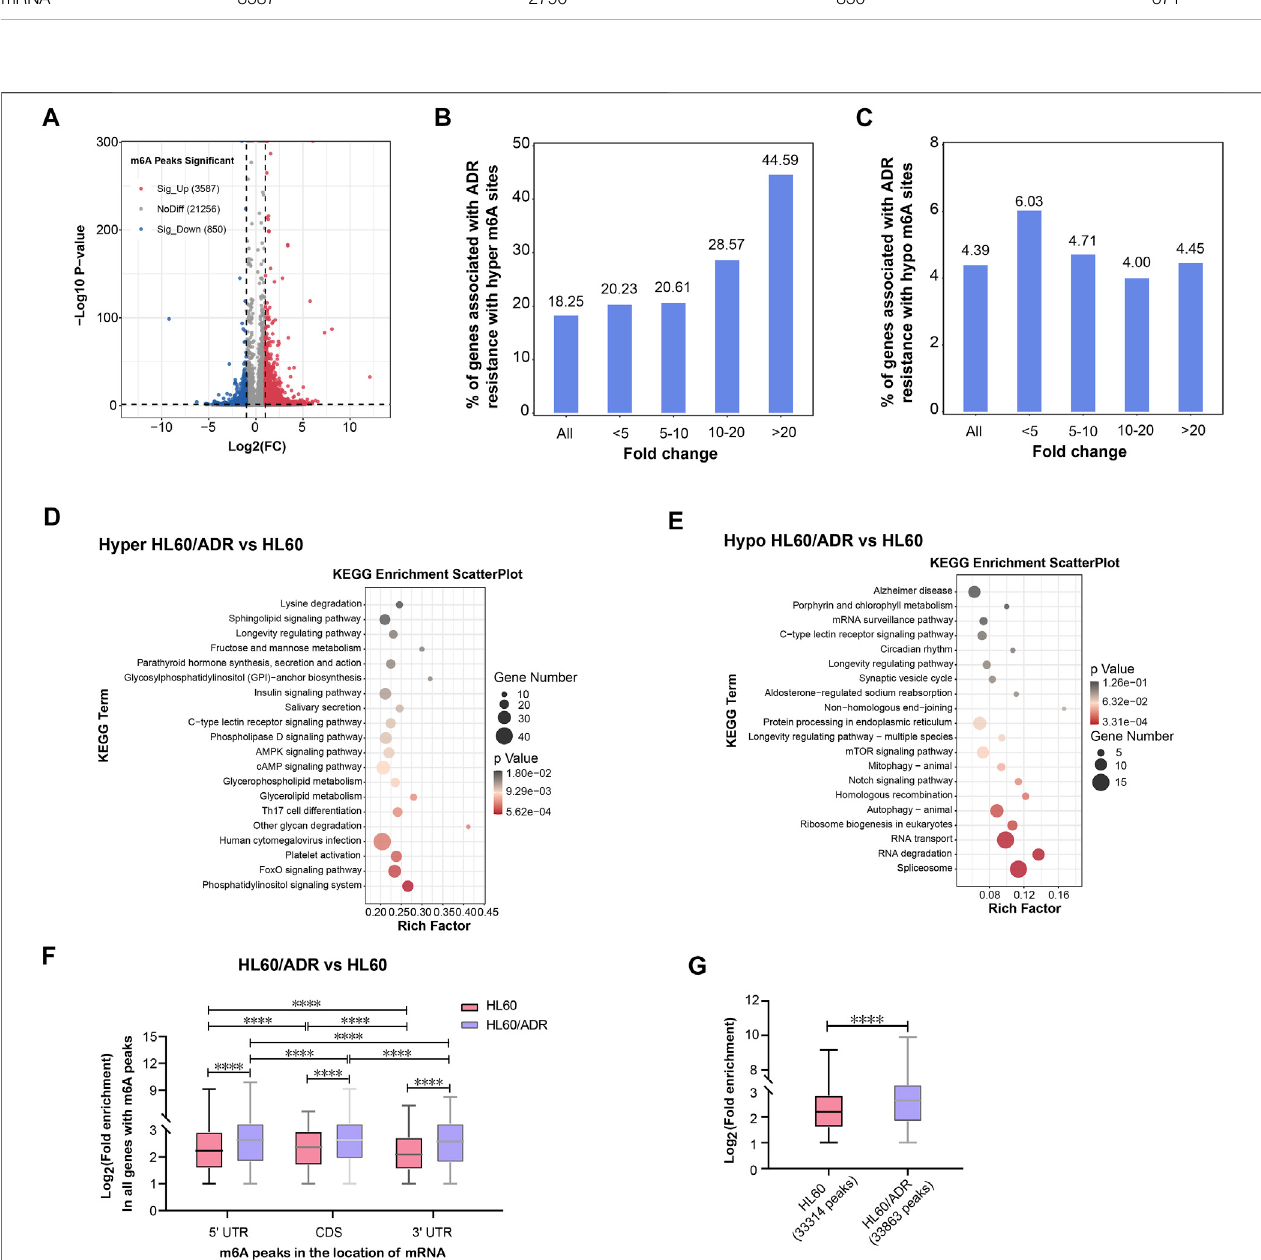
FIGURE 2 | Analysis of differentially methylated m 6 A-modi fi ed mRNAs. (A) Volcano plot of differential m 6 A peaks. Red and blue dots represent hyper-methylated and hypo-methylated peaks, respectively. (B) Percentage of hyper-methylated genes in all genes with m 6 A modi fi cation in HL60/ADR cells. (C) Percentage of hypo- methylated genes in all genes with m 6 A modi fi cation in HL60/ADR cells. (D,E) KEGG pathway analysis of genes with hyper- (D) or hypo-methylated (E) m 6 A peaks in HL60/ADR compared with HL60. Rich factor, signi fi cant gene number/background gene number. KEGG, Kyoto Encyclopedia of Genes and Genomes. (F)